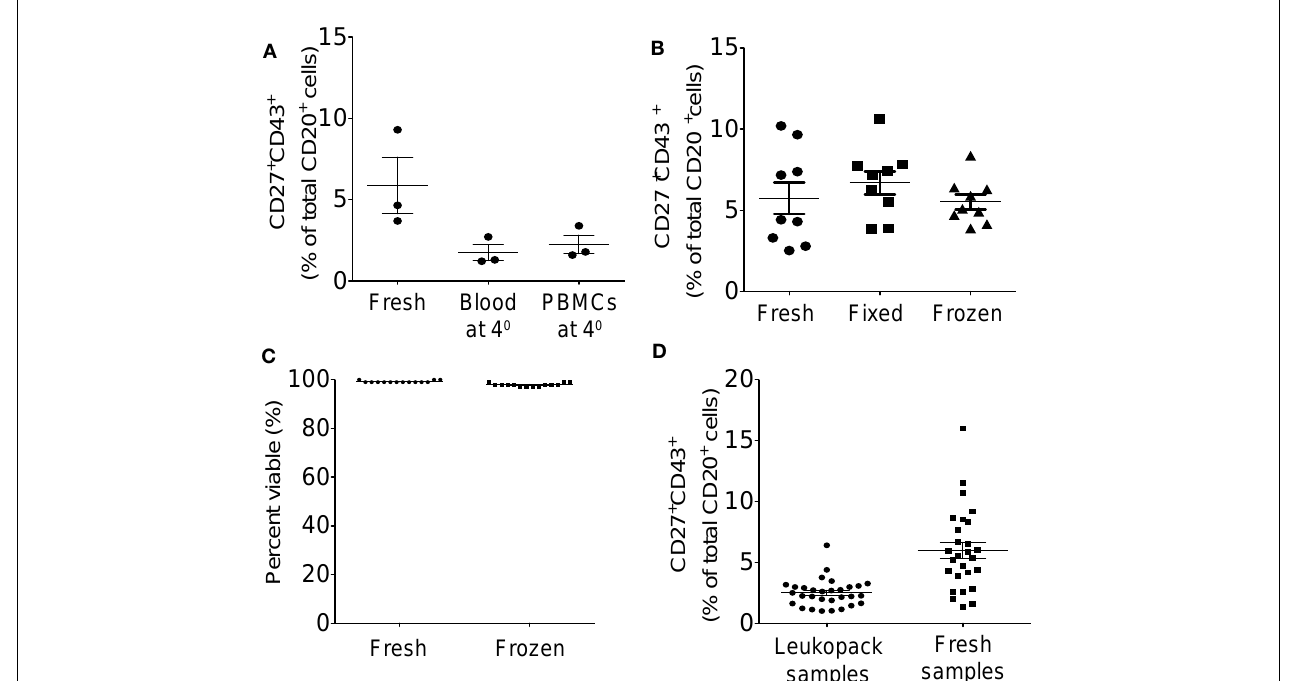
FIGURE 6 | Peripheral blood samples should be analyzed immediately or frozen or fixed for later analysis, and within these parameters fresh samples are preferable to leukopack samples. (A) Adult peripheral blood samples were processed immediately and then stained and analyzed immediately (Fresh), stored as whole blood for 24h at 4˚C before being processed and then stained and analyzed (Blood at 4˚), or processed immediately and stored as PBMC for 24h at 4˚C before being stained and analyzed (PBMC at 4˚).Three independent determinations of identified different approaches, along with lines indicating mean values and standard errors of the means. (B) Adult peripheral blood samples were